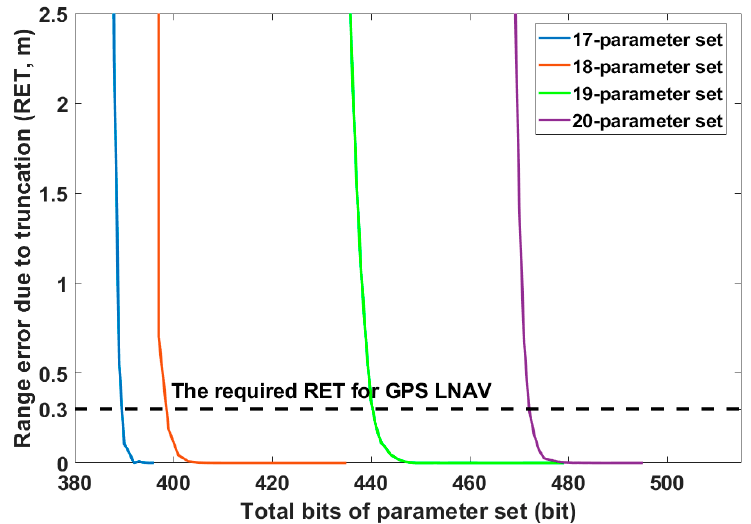
Figure 4. Total bits vs. RET for different ephemeris parameter sets.